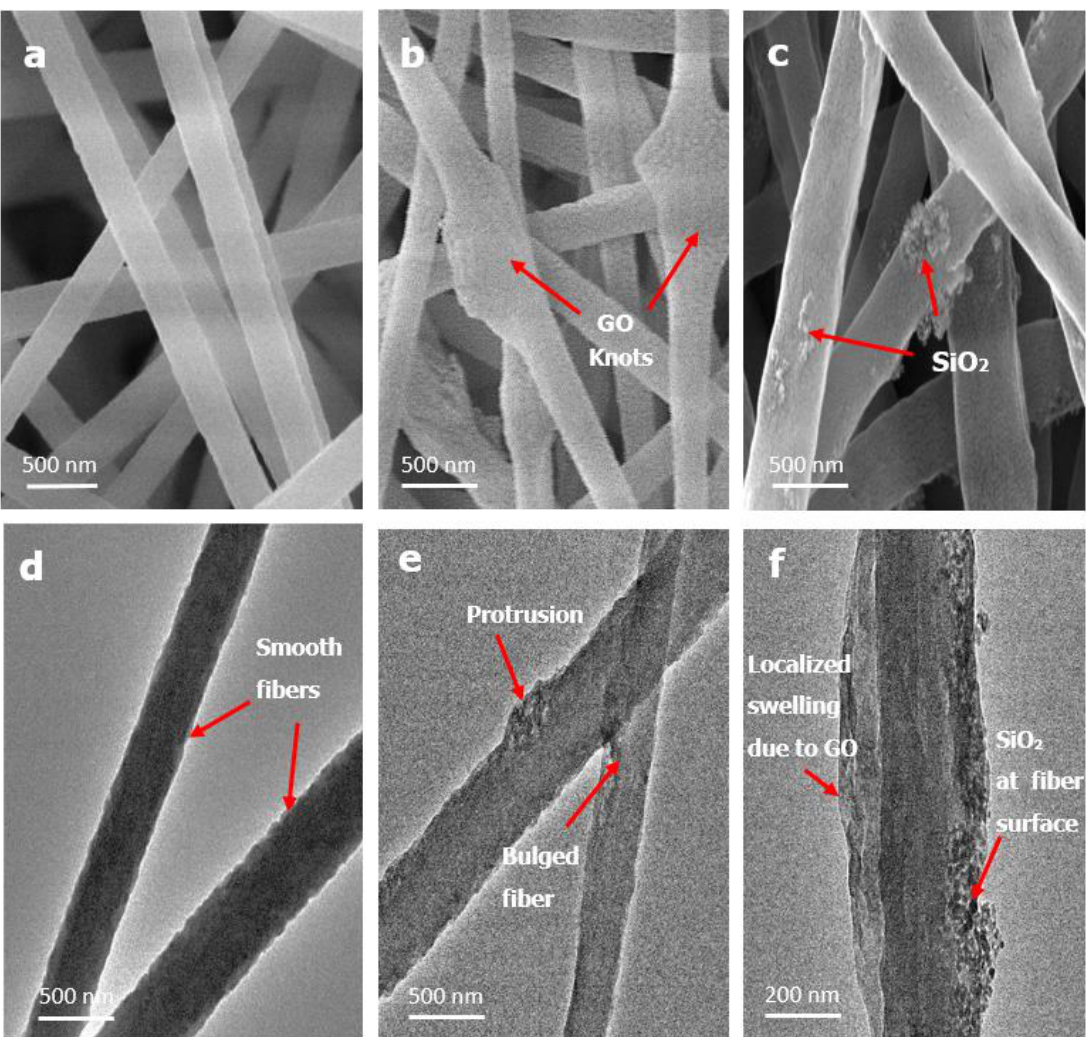
Figure 3. ( a ) SEM image of PAN nanofibers, ( b ) SEM image of fibers in PAN-GO membrane, ( c ) SEM image of fibers in PAN-SiO 2 membrane, ( d ) TEM image of PAN nanofiber, ( e ) TEM image of fibers in hybrid membrane, ( f ) high magnification TEM image of fiber in hybrid showing nanofillers at bulged region.